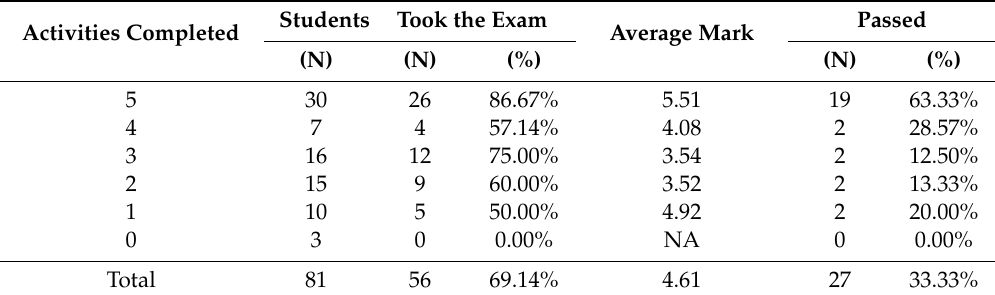
Table 5. Results obtained for those students that enrolled in any of the groups formed for activities according to the number of activities completed.